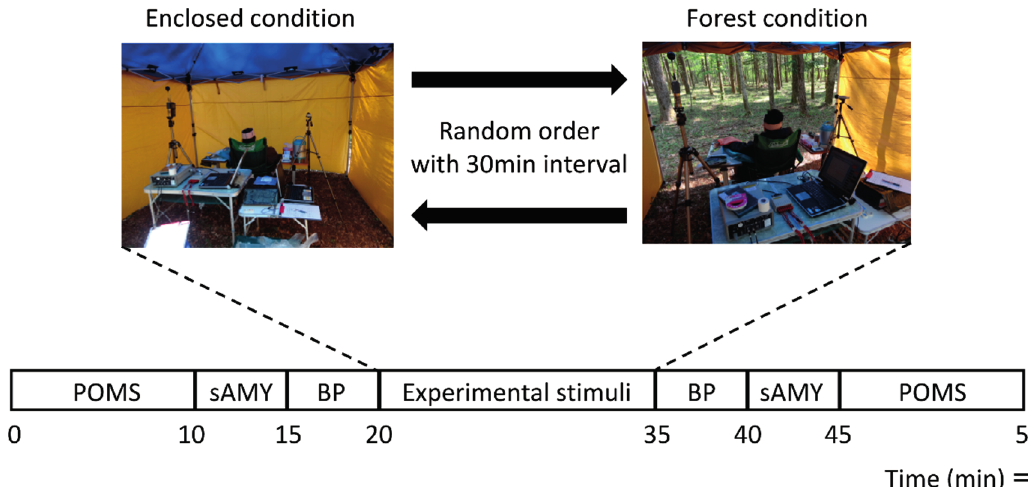
Figure 1. Experimental set-up of the Enclosed and Forest conditions. POMS, Profile of Mood States; sAMY, saliva amylase; BP, blood